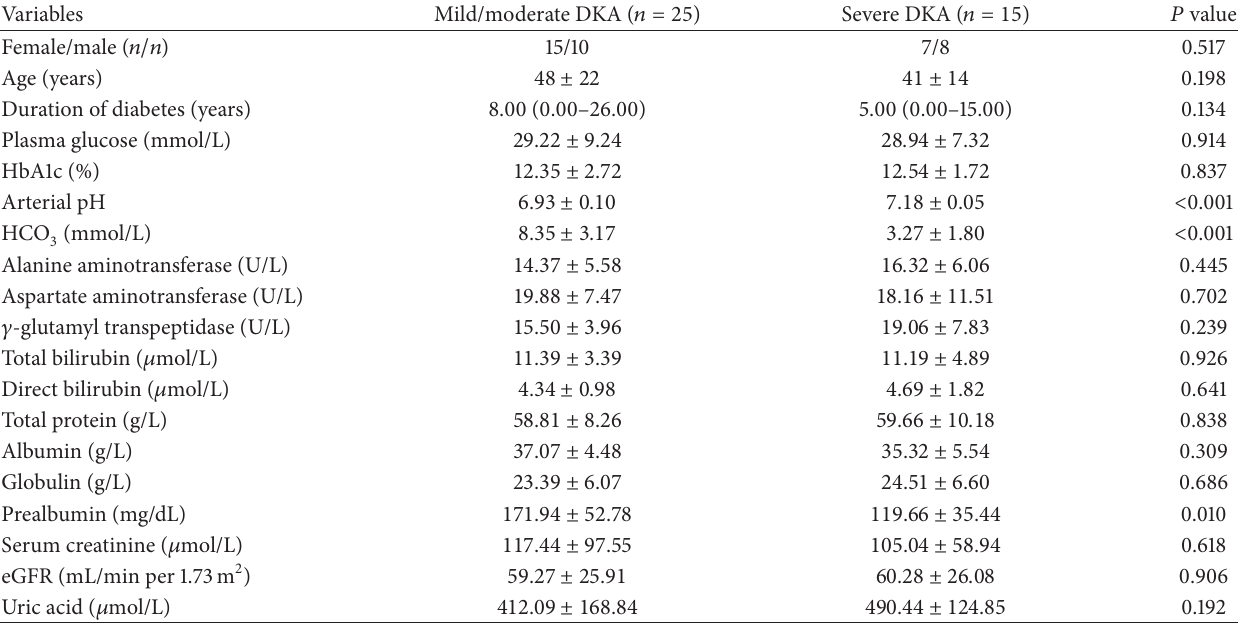
Table 4: Clinical and biochemical characteristics of the mild/moderate and severe DKA patients at